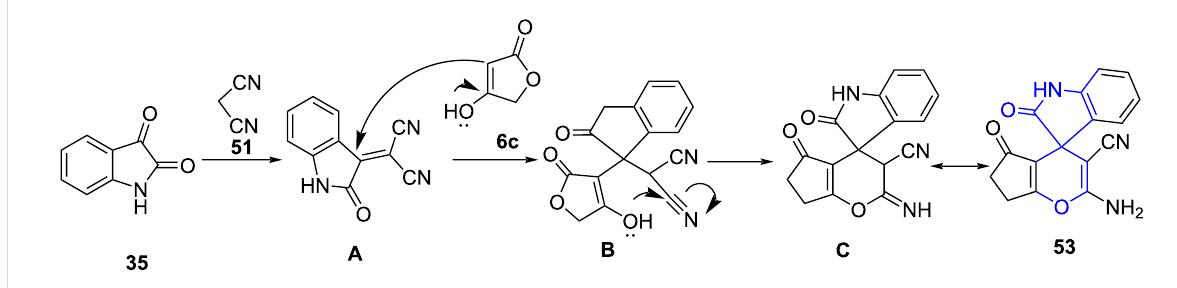
Scheme 20: Proposed mechanism for indoline-spiro-fused pyran.